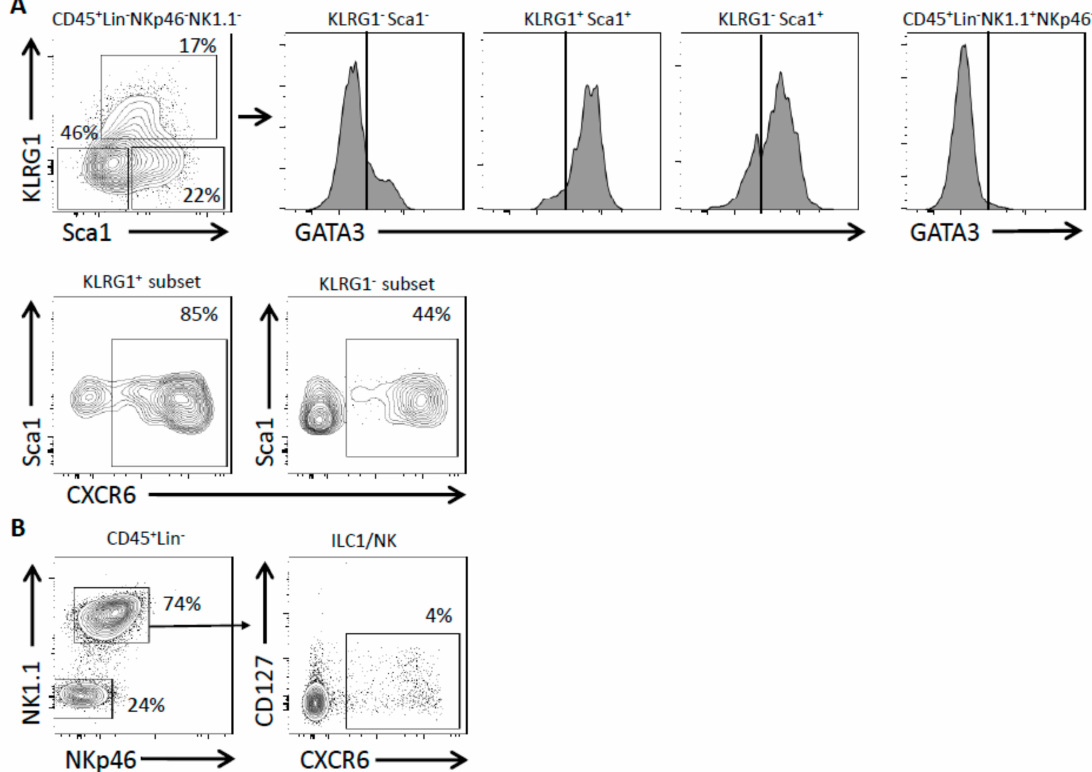
Figure 1. CXCR6 is expressed by lung ILCs. ( A ) Flow cytometry analyses of CD45 + Lin − (CD3, CD5, CD19, TCR β , TCR γδ , Gr1, Ter119, CD8 α and F4 / 80) NKp46 − NK1.1 − lung cells from Rag − / − CXCR6 +/ GFP mice. Di ff erent subsets are distinguished depending on the expression of KLRG1, Sca1 and GATA3 (GATA3 negative control was performed on CD45 + Lin − NK1.1 + NKp46 + cells). Sca1 and CXCR6 expression from KLRG1 + and KLRG1 − populations (graphs are representative of n = 6). ( B ) Flow cytometry analyses of CD45 + Lin − lung cells from Rag − / − CXCR6 +/ GFP mice. CD127 and CXCR6 expression among ILC1 / NK (NK1.1 + NKp46 + ) cells (graphs are representative of n =